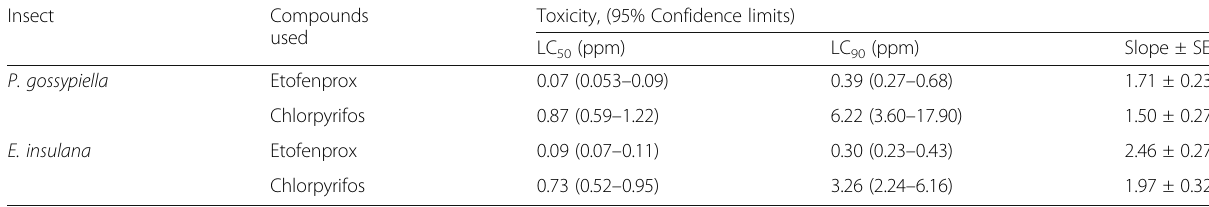
Table 1 Toxicological evaluation of etofenprox and chlorpyrifos against newly hatched larvae of P. gossypiella and E. insulana under laboratory conditions Insect